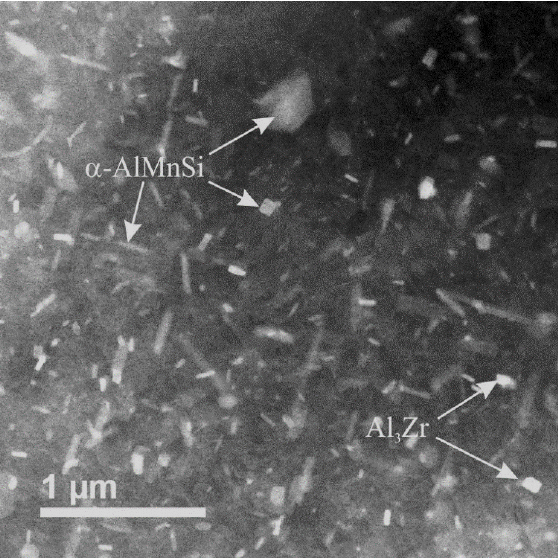
Figure 7. Dispersoids in α -Al after homogenization. The High-Angle Annular Dark Field (HAADF) image in TEM.